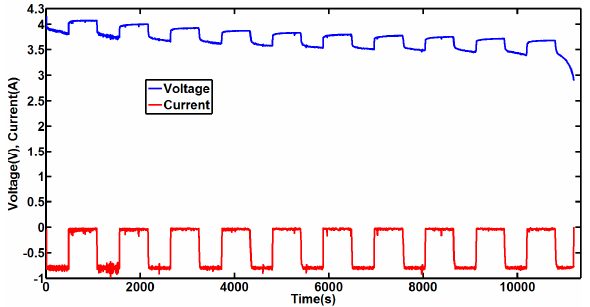
Figure 3. Discharge current and battery terminal voltage.